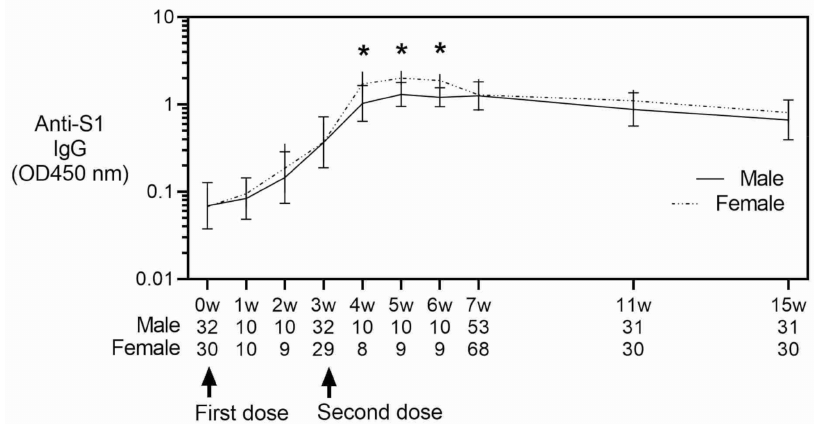
Figure 2. Sex differences in SARS-CoV-2 S1 protein-specific antibody levels. Antibody titers measured by CLEIA (upper panel) and ELISA (lower panel) are shown. Data rep-resent least square geometric mean ± geometric standard error estimated by mixed model; interac-tions between sex and time course were tested in a mixed model considering sex, age, steroid use, and number of weeks (categorical variables) as fixed effects and repeated measures of the same subject and target population (healthcare workers, hospital staff, and students) as random effects. *, p < 0.05; #, p = 0.056 for interactive effects (sex × time). In total, forty-two students (vaccinations started in May 2021) had blood specimens collected before vaccination and at three, seven, elev-en, and fifteen weeks after vaccination. Twenty healthcare workers (vaccinations started in April) had blood specimens collected at all time points. Fifty-nine hospital staff (vaccinations started in February) had blood specimens collected seven weeks after the first vaccination. Arrows indicate vaccination timing. One male student lacked measurements after 11 weeks. One female healthcare worker lacked measurements at week two and after four weeks. Another female healthcare worker lacked a measurement at week four.